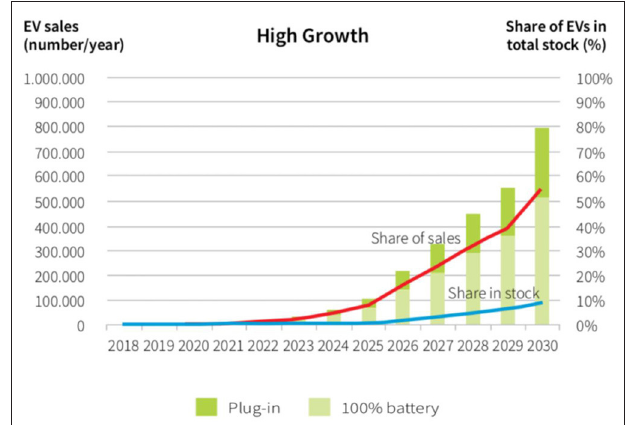
FIGURE 1 | Total number of electric vehicle car estimations until 2030 in Turkey. Source: Shura Energy Transition Center, Transport Sector Transformation: Integrating Electric Vehicles into Turkey’s Distribution Grids,